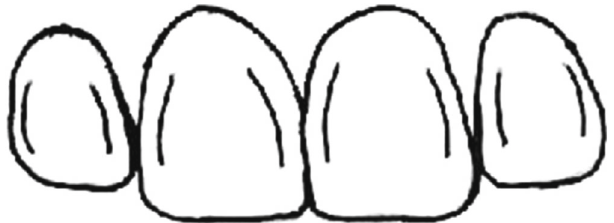
Figure 1: Facial Line angles symmetry with contralateral tooth.